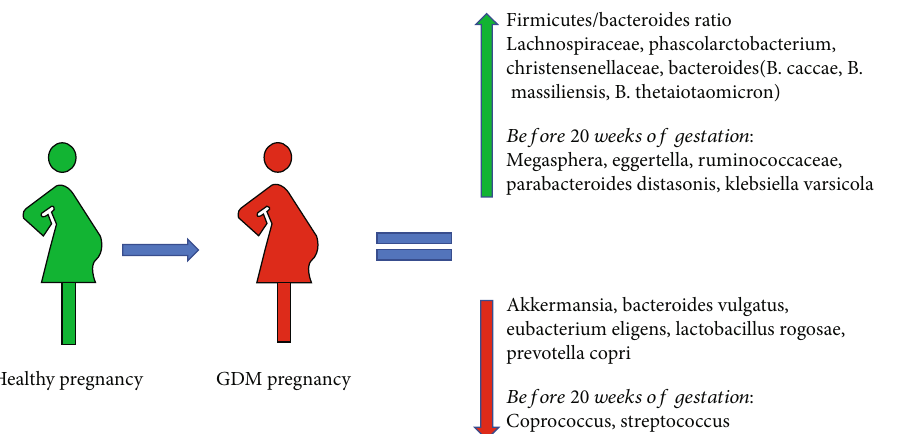
Figure 2: Di ff erences in the gut microbiota between healthy pregnancy and GDM